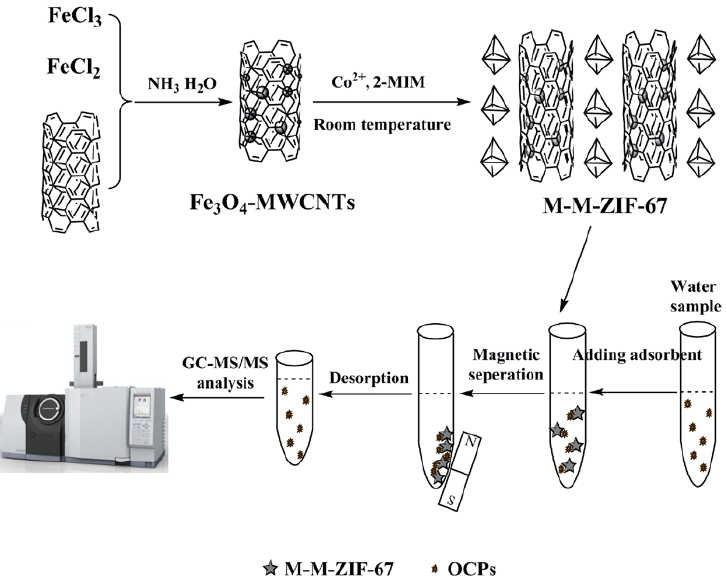
Figure 1. Schematic illustration of the synthetic route to prepare zeolitic imidazolate framework based on magnetic multiwalled carbon nanotubes and the magnetic solid-phase extraction steps for organochlorine pesticides analysis.